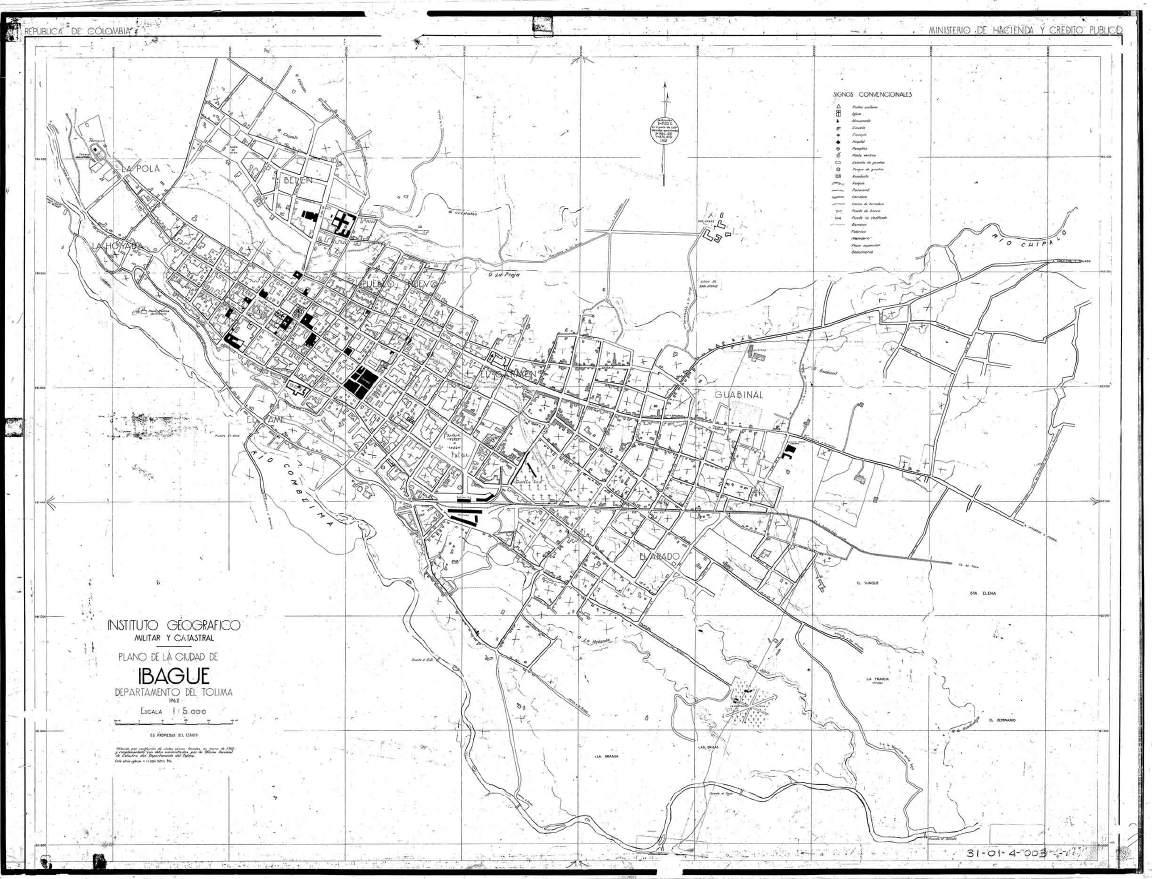
Figure 2. Map of Ibague City 1942. Obtained by restitution of aerial views taken in January 1940 and complemented with data supplied by Cadastre Sectional Office of Department of Tolima. Geographical and Military Cadastral Institute